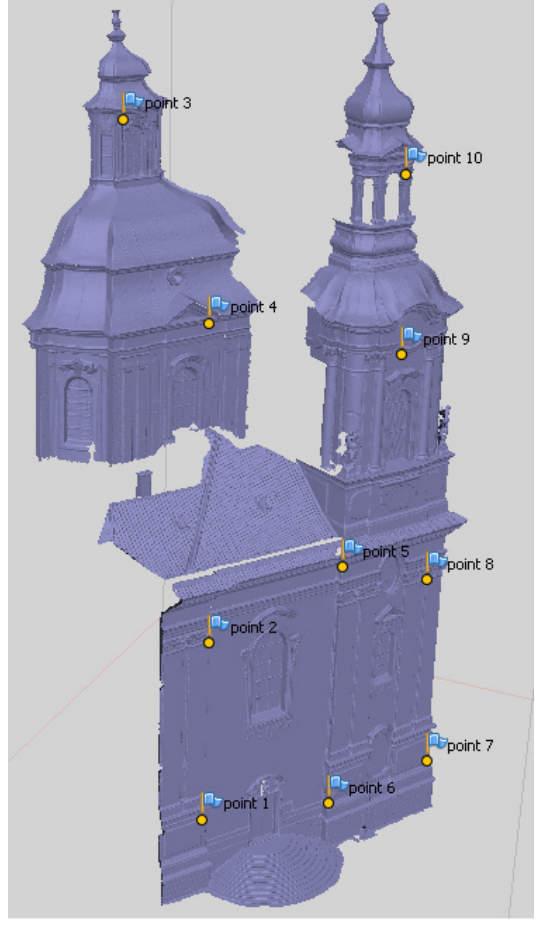
Figure 5. Control points selection on the west